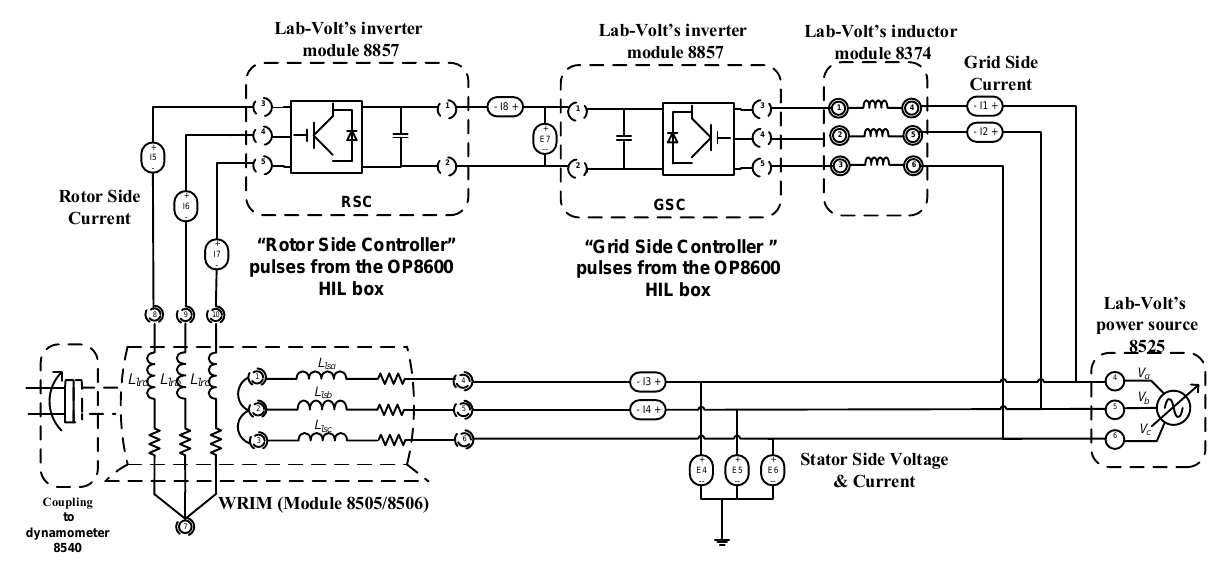
Figure 3. Experimental setup to emulate WECS.